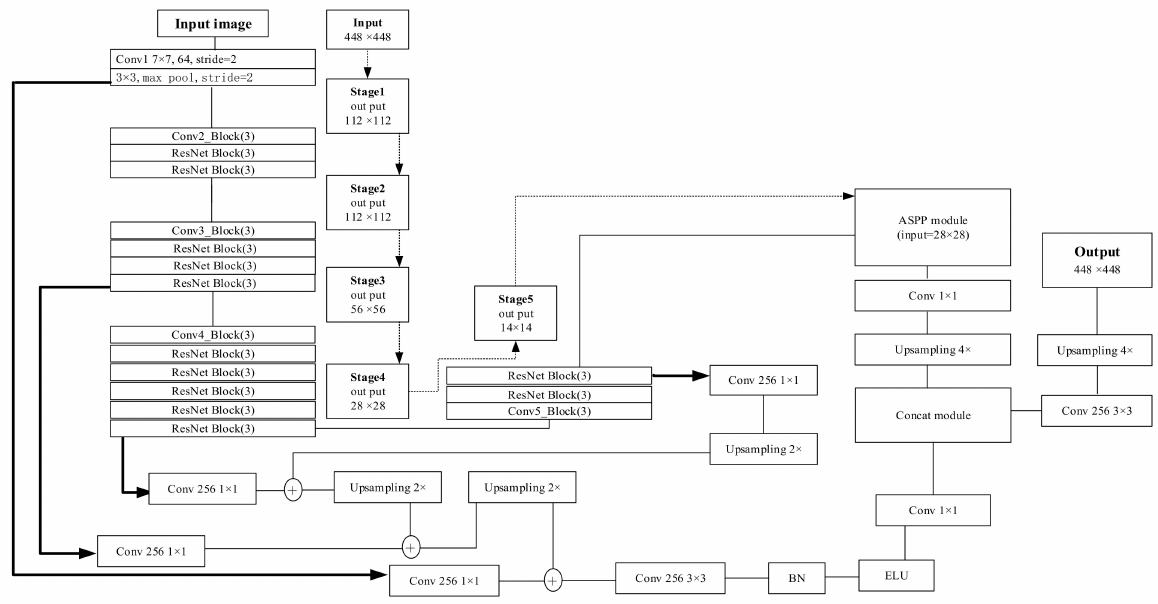
Figure 6. Network workflow of the proposed method ( means element-wise